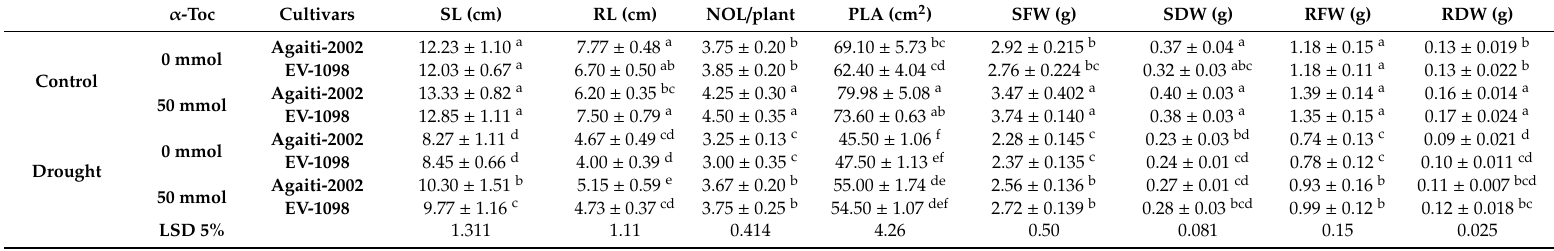
Table 1. Influence of foliar-applied alpha tocopherols on di ff erent growth and morphological attributes of maize cultivars grown under di ff erent water regimes (mean ± SE; n = 3). SL = shoot length; RL = root length; NOL = number of leaves; PLA = plant leaf area; SFW = shoot fresh weight; SDW = shoot dry weight; RFW = root fresh weight; RDW = root dry weight; α -toc = alpha tocopherol.